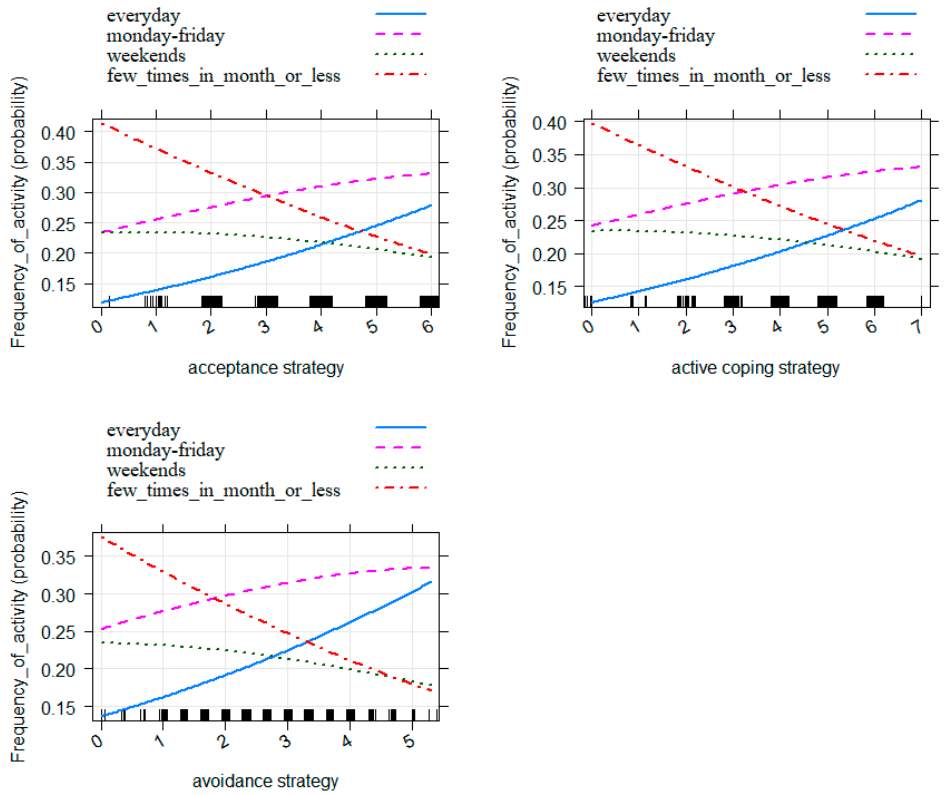
Figure 4. Types of recreational activity response for significant strategies from the Brief-COPE Inventory (7 strategies) (source: own computations).